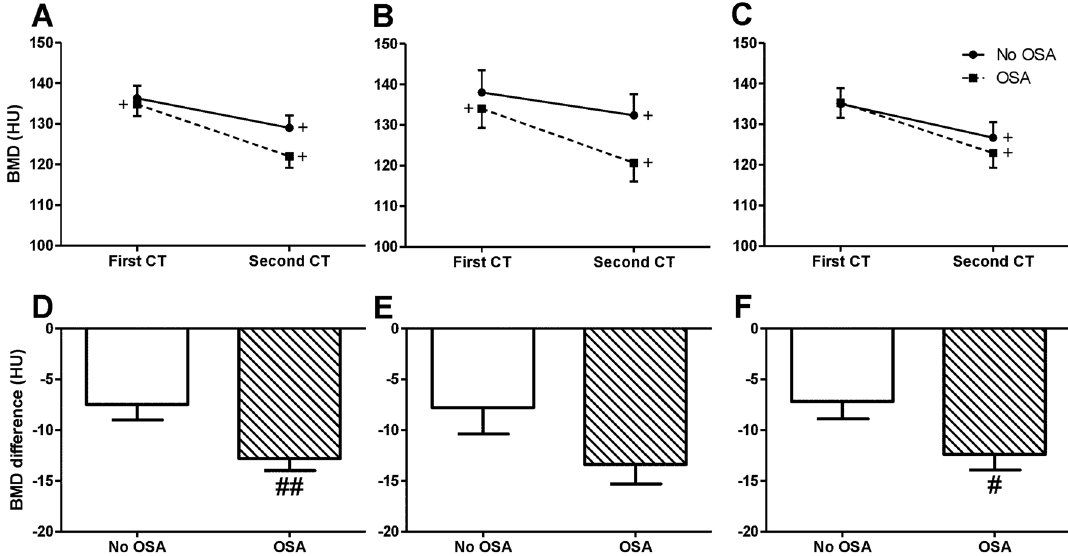
Figure 2. Vertebrae bone mineral density. ( A ) Vertebra BMD for the entire group, ( B ) women’s BMD, ( C ) men’s BMD, ( D ) DIFF for the entire group, ( E ) DIFF for women, ( F ) DIFF for men. Data showing mean BMD of the 12 thoracic vertebrae and first lumbar vertebra; BMD bone mineral density, DIFF difference in HU between the first and second CT scans. HU Hounsfield units, OSA obstructive sleep apnea. # p < 0.05, ## p < 0.01 first scan vs. second scan BMD. Statistical differences were determined by a two-tailed t test. + p < 0.01, no-OSA vs. OSA, statistical differences were determined by a 2-way repeated measures ANOVA.